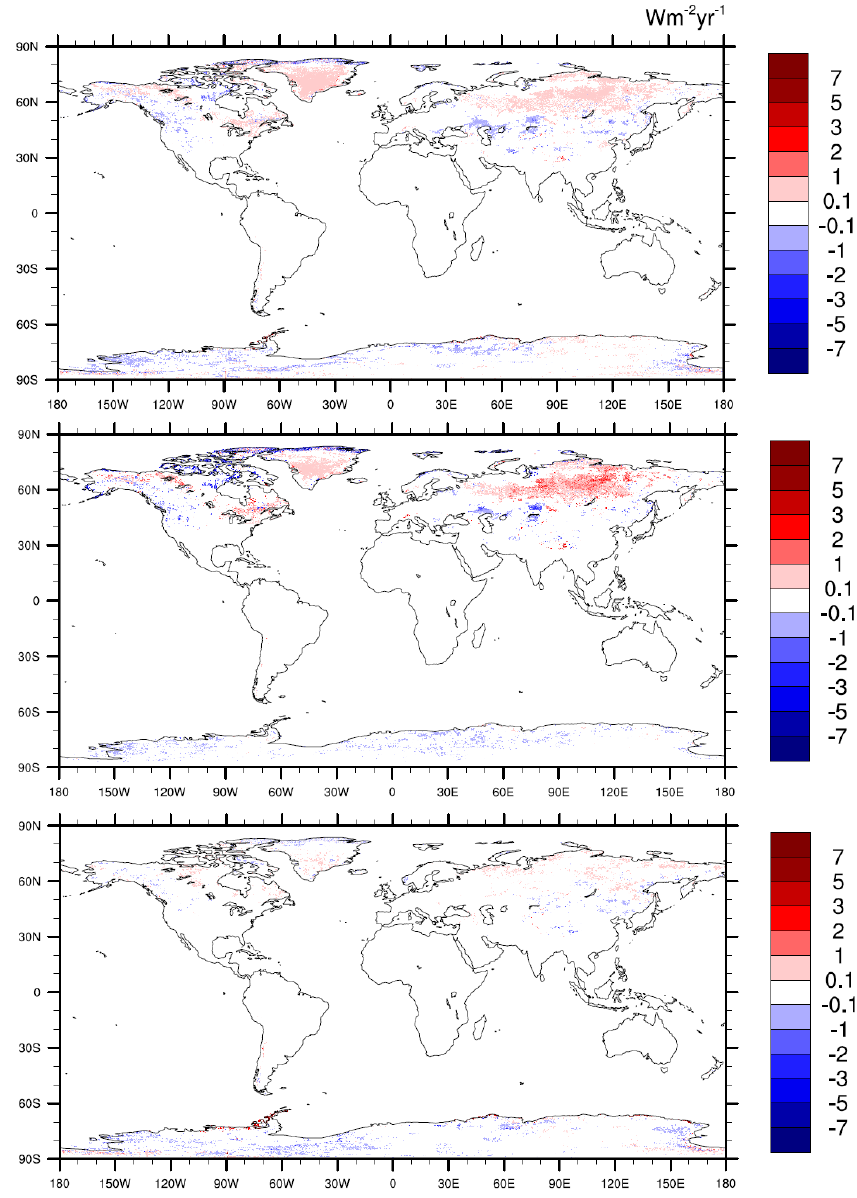
Figure 8. LCrRE trend maps for annual (top panel), MAM (middle panel) and SON (bottom panel) seasons (MAM – March, April, May; SON – September, October, November). Trends were derived using Mann–Kendall regression technique. Only regions with significant trends ( p = 0.05) are shown in the